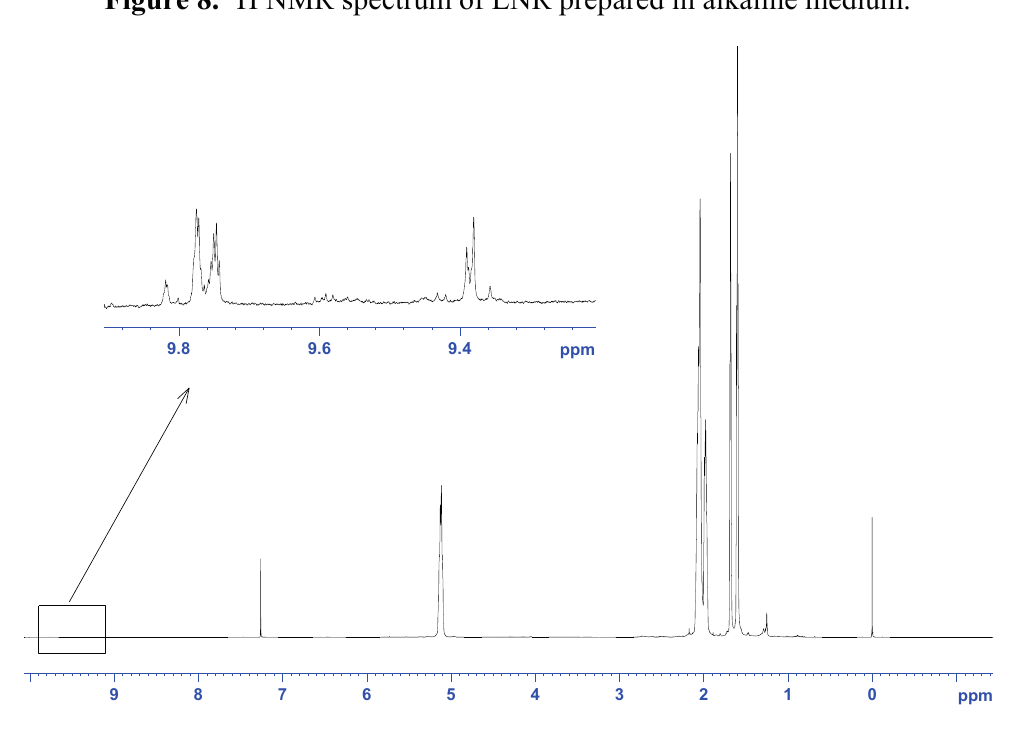
Figure 8. 1 H NMR spectrum of LNR prepared in alkaline